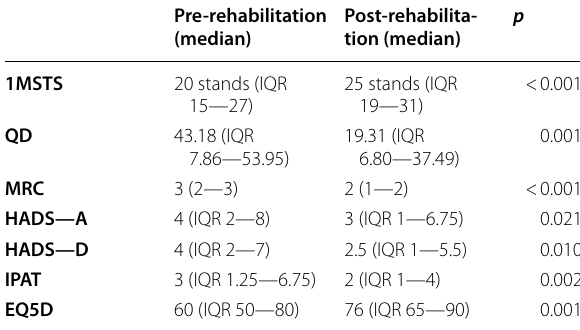
Table 2: Results of physical and non-physical outcomes pre and post rehabilitation (n =